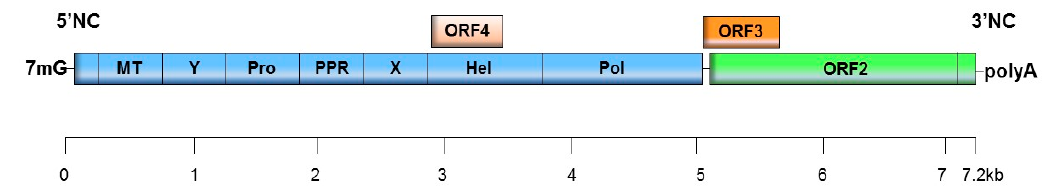
Figure 1. Hepatitis E virus (HEV) genome. Open reading frames (ORF1) (blue box) encodes nonstructural proteins. ORF4 has been found only in HEV1. 7 mG: 7-methylguanosine; Hel: helicase; MT: methyl transferase; polyA: polyadenylated tail; PPR: polyproline region; Pro: cysteine